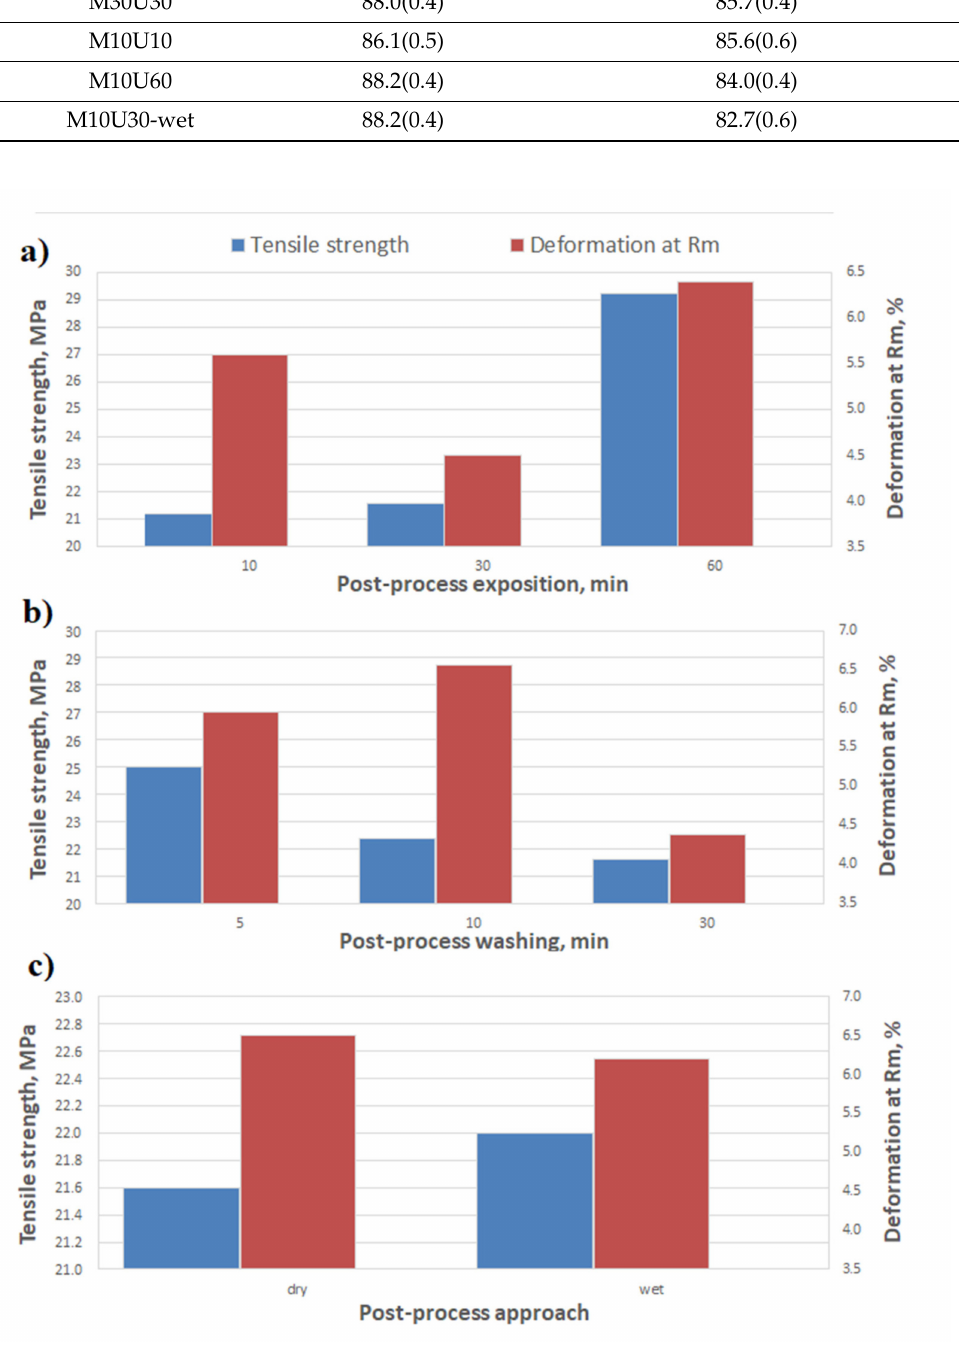
Figure 3. Tensile strength of printed samples, depending on the following: ( a ) post-curing exposition time, ( b ) post-process washing time, ( c ) post-process approach—post-curing in water